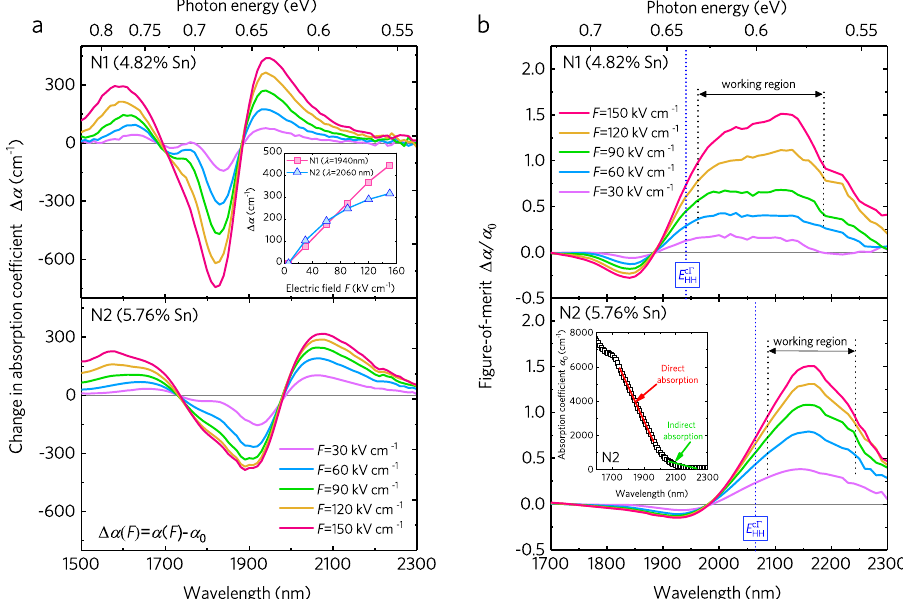
Fig. 4 Franz – Keldysh effect in GeSn. a Change in the absorption coef fi cient in the GeSn active layers at different electric fi elds for devices N1 (upper panel) and N2 (lower panel). The inset shows the change in the absorption coef fi cient for device N1 and device N2 at λ = 1940 and λ = 2060nm, respectively, as a function of electric fi eld. b Figure-of-merit (FOM) Δ α / α 0 for the GeSn active layer at different electric fi elds for devices N1 (upper panel) and N2 (lower panel). The lowest direct bandgap is indicated by the dashed blue lines. The inset shows the absorption coef fi cient spectrum under the zero-bias condition of device the inset of Fig. 4b. As a result, the FOM is enhanced, suggesting optical modulation. We can also de fi ne the optimal modulation range of the devices based on the FOM. For device N1 (4.82% Sn), as shown in Fig. 4b, the FOM at F = 150 kV cm − 1 is always